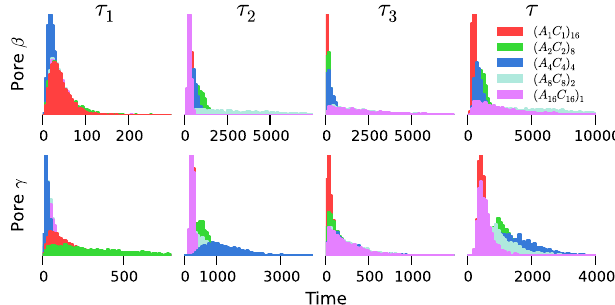
FIG. 11. Comparison of the filling, transfer, escape, and trans- location time distributions for the Pores (cid:3) and (cid:4) at F ¼ 0 : 5 and W ¼ 2 : 5 using heteropolymers with different sequences. Translocation through Pore (cid:2) is extremely slow for this range of values and is not considered for this